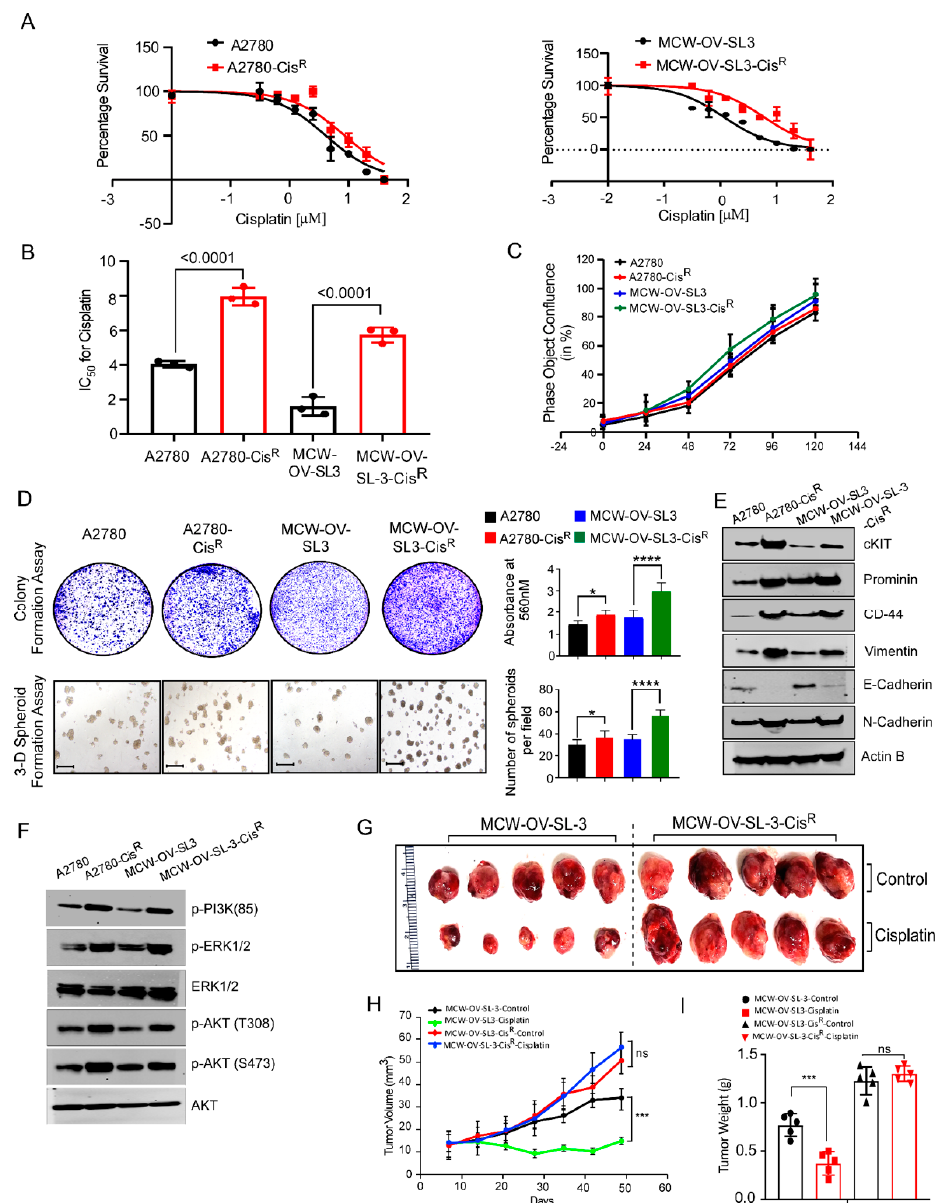
Figure 4. Cisplatin ‐ resistant MCW ‐ OV ‐ SL3 cells exhibit hyperproliferation and aberrant PI3K/AKT activation. ( A ) Cisplatin ‐ sensitive and resistant versions of A2780 and MCW ‐ OV ‐ SL ‐ 3 cells were grown in the presence of different concentrations of cisplatin for 48 h and then cell viability was determined using MTT. Error bars represent standard error of the mean. ( B ) IC50 of cisplatin ‐ sensi ‐ tive and resistant A2780 and MCW ‐ OV ‐ SL3 cells were determined from three independent cell via ‐ bility experiments performed using MTT. ( C ) Cisplatin ‐ sensitive and resistant of A2780 and MCW ‐ OV ‐ SL3 cells (3500 cells/well of each cell line) were seeded in 96 ‐ well culture plates and cell prolif ‐ eration was assessed as percent confluency using an Incucyte S3 live ‐ cell analysis system for a pe ‐ riod of 120 h. ( D ) Cell lines (1000 cells/well) indicated were grown on six well culture plate for 14 days for colony formation, then stained using 0.5% crystal violet and photographed. For 3D for ‐ mation assay, 3000 cells were grown on Matrigel ‐ coated plates for seven days and then photo ‐ graphed using phase ‐ contrast microscope. Scale bars represent 500 μ m. The bar graph on right re ‐ veals the quantification of the colony formation and 3D spheroids of indicated cell lines. ( E , F ) Cell lysates were prepared from cisplatin ‐ sensitive and resistant A2780 and MCW ‐ OV ‐ SL3 cells and im ‐ munoblot was performed with indicated antibodies. β‐ actin was used as a loading control (see Fig ‐ ure S3). ( G ) MCW ‐ OV ‐ SL3 and MCW ‐ OV ‐ SL3 ‐ CisR (1 × 10 6 cells/mice) were injected